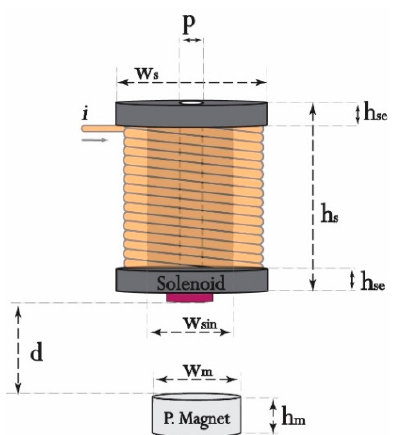
Figure 2. The EMAwS characteristics.